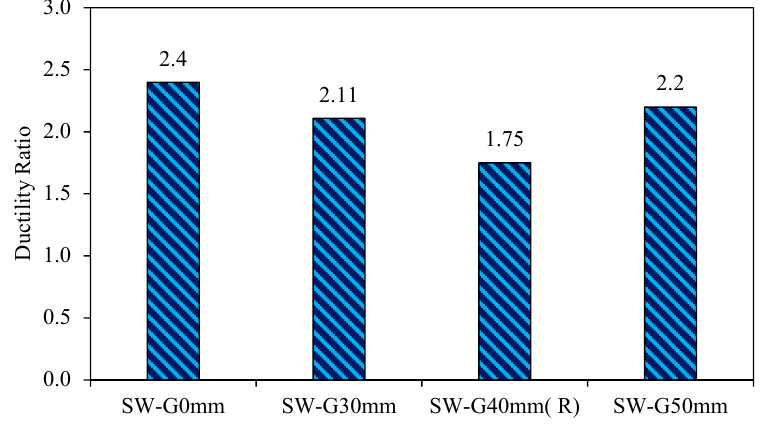
Figure 12. Ductility ratio of group